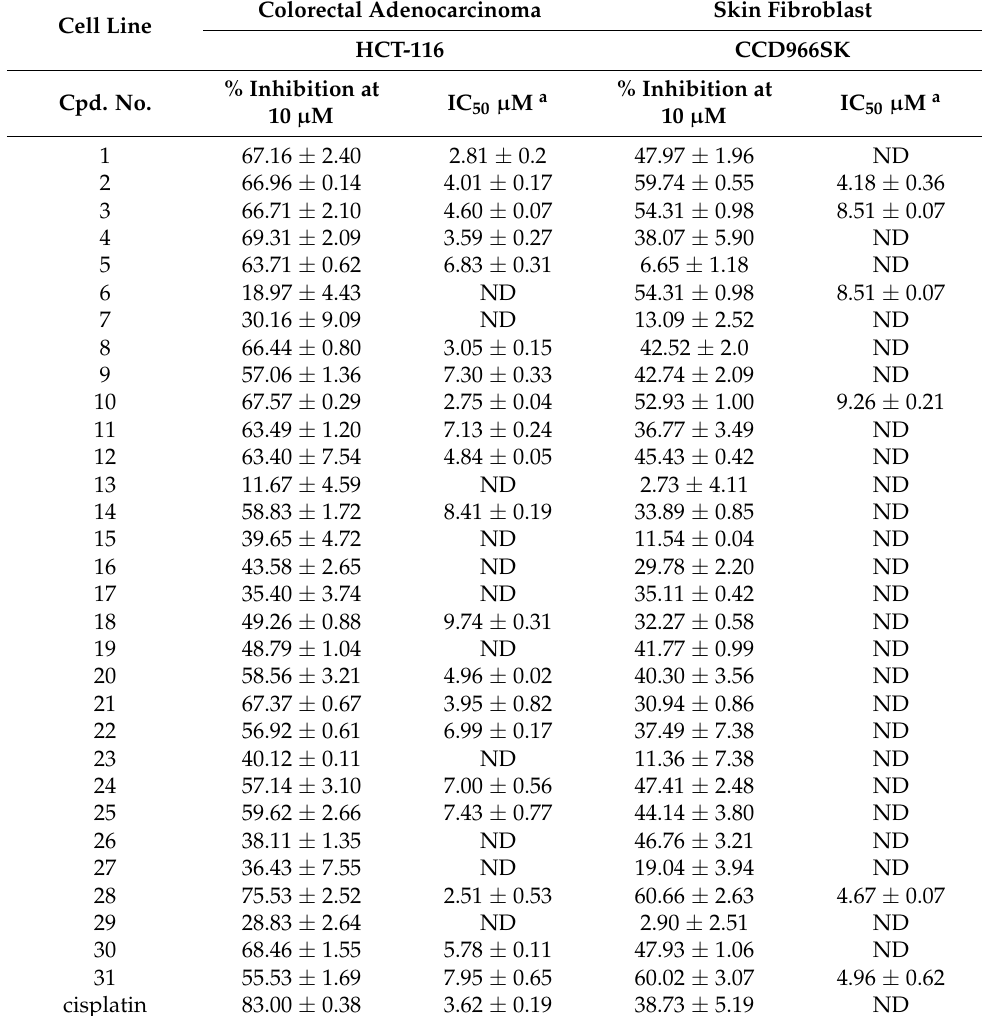
Table 3. Cytotoxic activity of the synthesized compounds against HCT-116 and non-cancer cell lines. Colorectal Cell Line